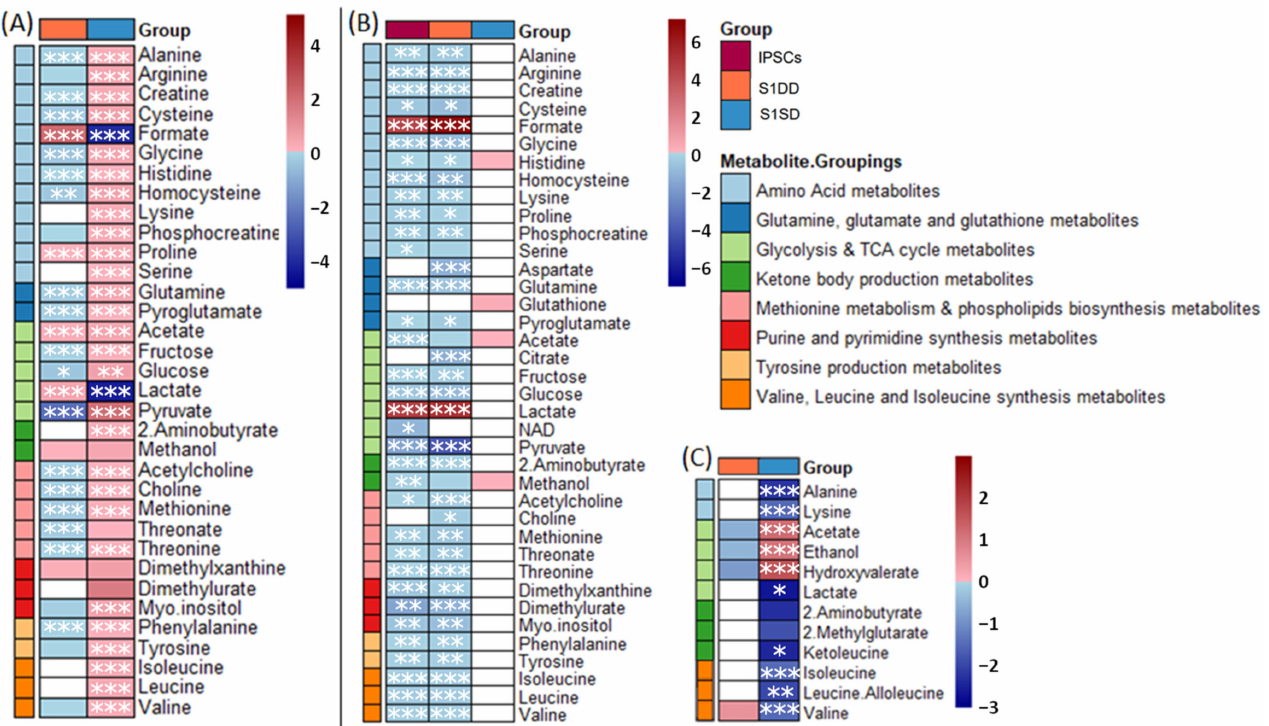
Figure 2. Fold change analysis of key metabolites between pluripotent IPSC and Stage 1 differentia- tion. ( A ) Intracellular metabolite changes (with baseline corrected to cell-free controls) for DD (blue) or SD (orange) versus IPSC; ( B ) Extracellular metabolite changes directly compared to the respec- tive cell-free controls for IPSC (red) DD (blue) or SD (orange); ( C ) Intracellular methyl-containing metabolites for DD (blue) or SD (orange) versus IPSC samples. For clarity, metabolites are grouped according to key cellular processes. Red cells indicate a fold-change increase, blue cells indicate a fold- change decrease. Cells left white were found to be neither significantly different (<0.05 FDR-adjusted p -value) nor with VIP > 1 (by multivariate discriminant analysis). Asterisks indicate FDR-adjusted p -values < 0.05 (*), < 0.005 (**), or < 0.001